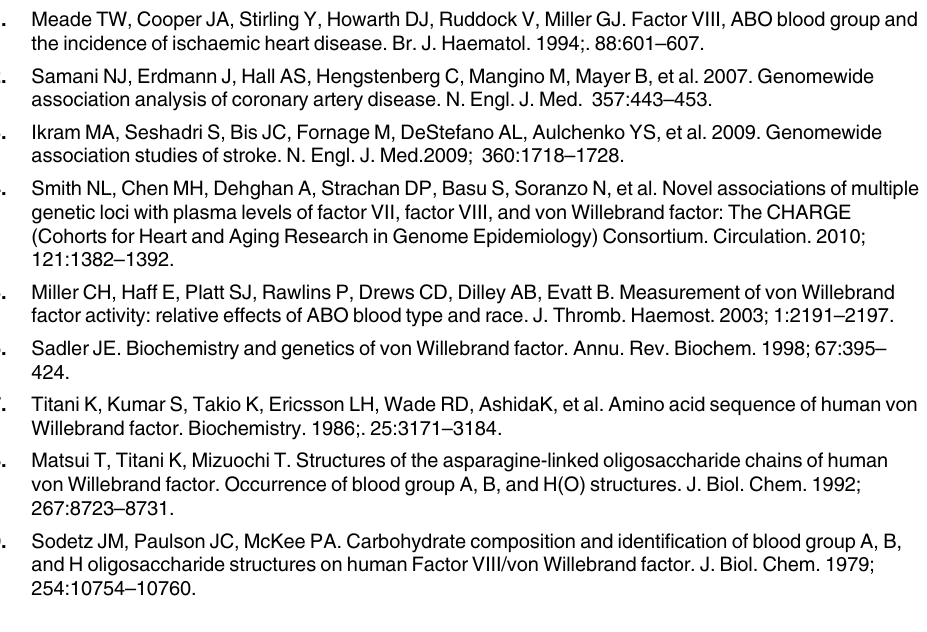
S1 Fig. Relationship between VWF and FVIII for the entire cohort samples: (A) the data after adjustment for environmental factors were analyzed using a regression model and (B) the least square trend line was plotted for the entire cohort samples. S2 Fig. Plots for ABO blood groups in each gender and race group presented with regres- sion line. S1 Table. SNP Used for Genotyping ABO Blood